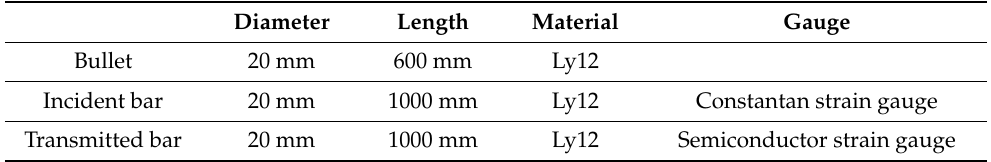
Table 3. Experimental conditions of SHPB